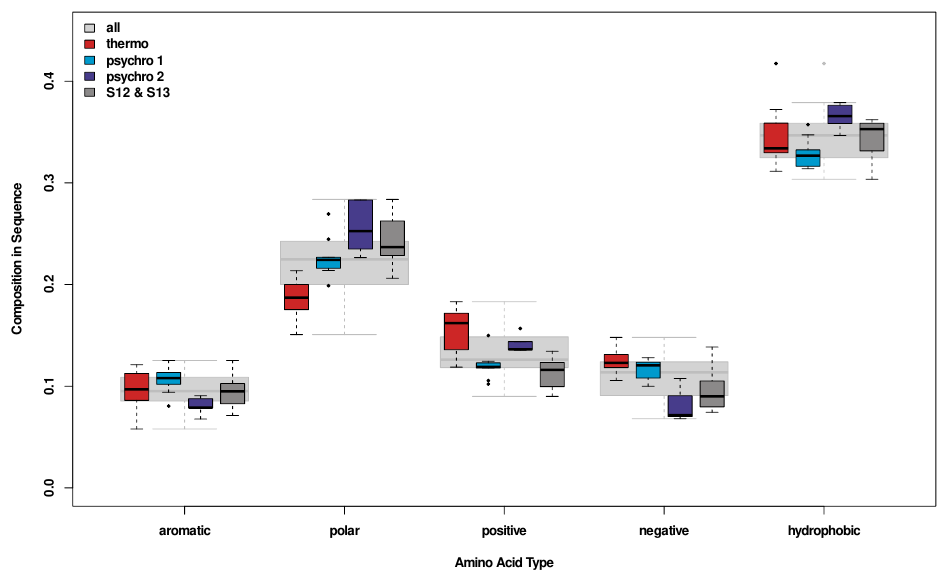
Figure 3. Differences in overall composition by amino acid type. Thermophiles are relatively exiguous in uncharged polar amino acids and enriched in charged residues. On the other hand, psychrophiles are relatively enriched in uncharged polar residues; however, their composition differs considerably by sequence